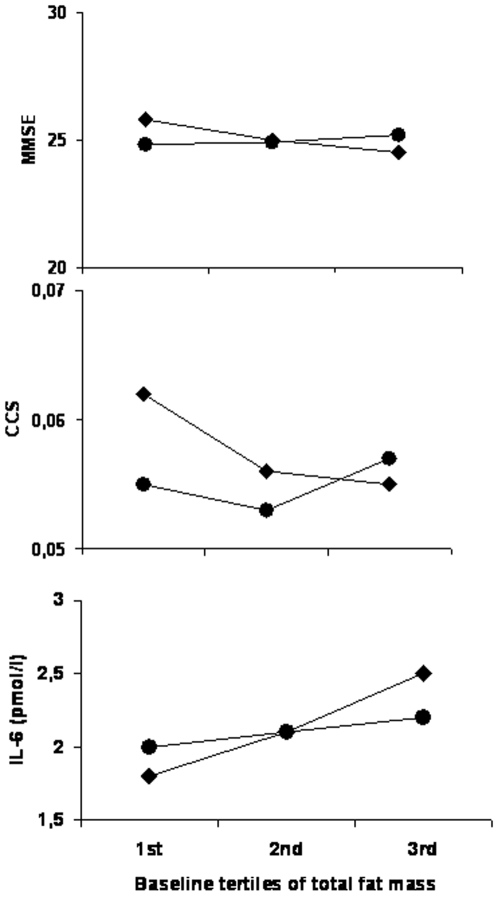
Figure 2 shows MMSE scores, CCS and IL-6 levels across baseline tertiles of total fat mass in persons with DM and NGT; (p for trend <0.05 in DM only for all figures).(black diamonds: DM; black circles: NGT).